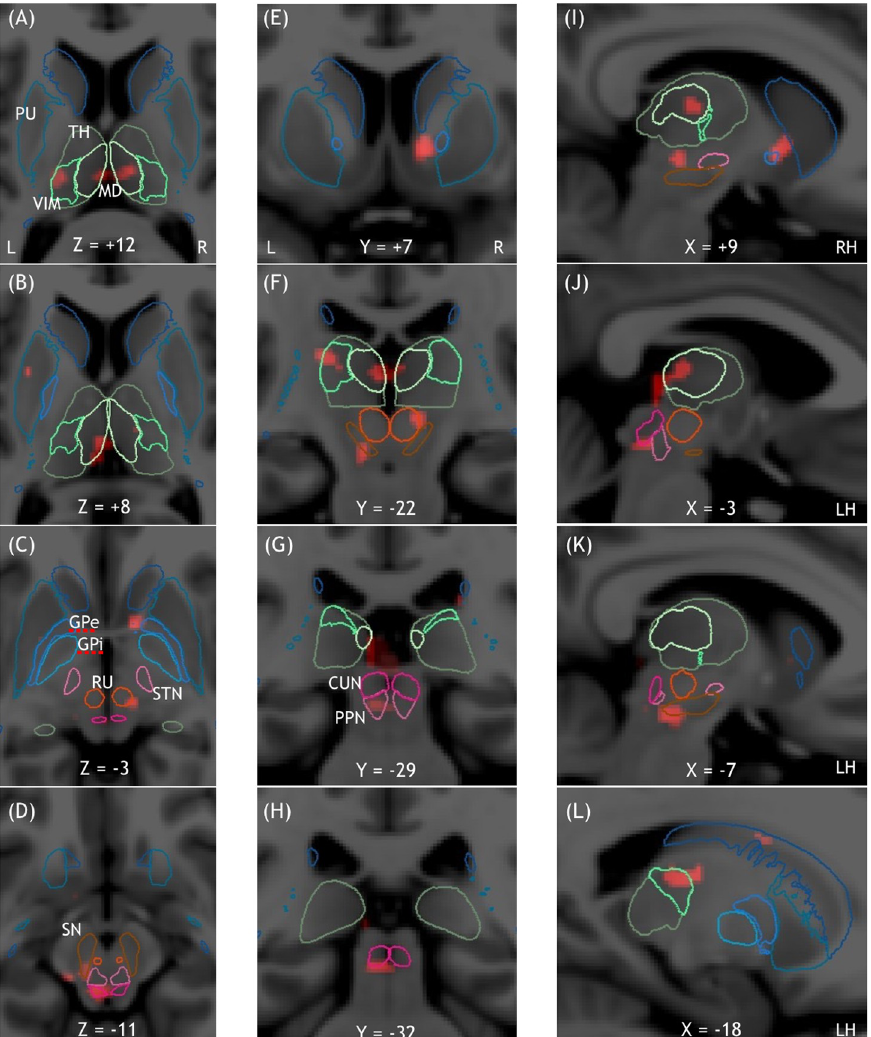
Fig 3. Midbrain clusters of the GAIT -WALKWAY contrast represented overlaid on the MNI152 template. The contours of the nuclei of the thalamus, the basal ganglia, and the MLR are given by the YeB atlas mapped to the MNI template. Midbrain and MLR clusters are shown in horizontal (A, B, C, D), frontal (E, F, G, H), and sagittal (I, J, K, L) sections. GAIT -WALKWAY showed clusters in the thalamus (VIM (left) and MD nuclei) (A, B, F, I, J, L), left caudate nucleus (L), left putamen (B), right red nucleus (C), left substantia nigra (D, K), and left CN and PPN (D, G, H, J).